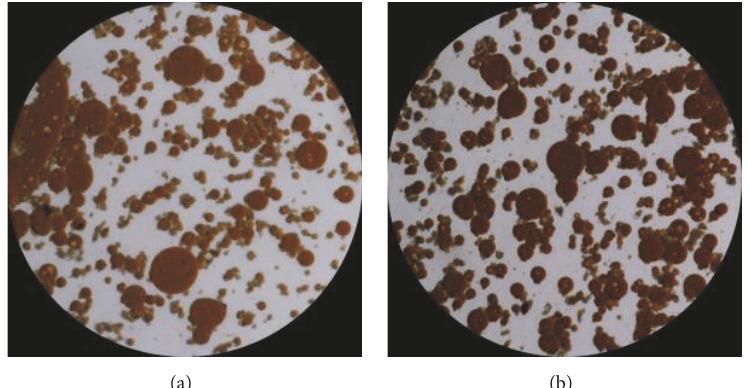
Figure 10: Micrographs of produced fluids in different production periods when chemical solution was injected: (a) in the earlier production period; (b) in the later production period.